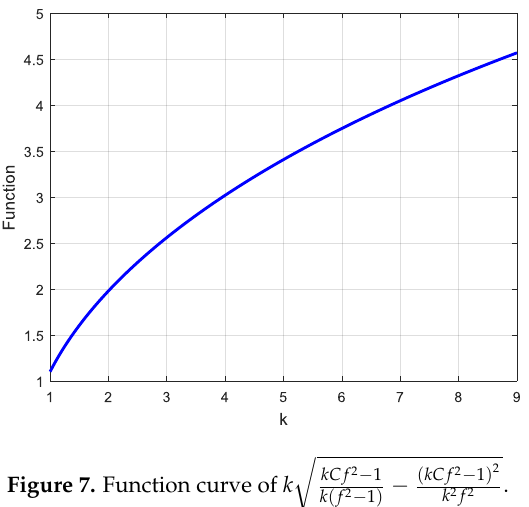
Figure 7. Function curve of k